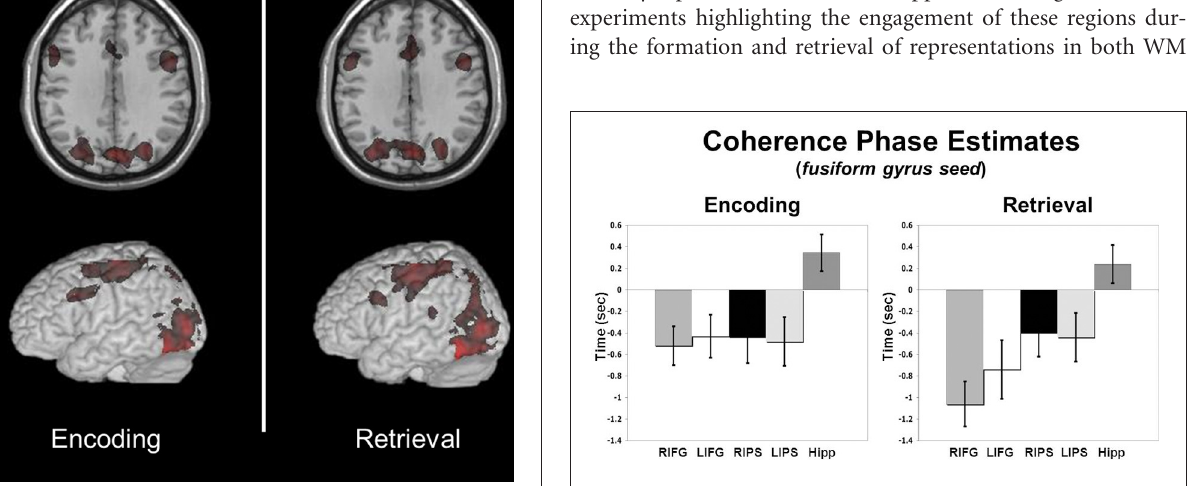
FIGURE 3 | Coherence phase delay measures for IFG, IPS, and hippocampus relative to the right fusiform gyrus seed which is represented here as time zero on the x -axis (error bars reflect standard error of the mean,